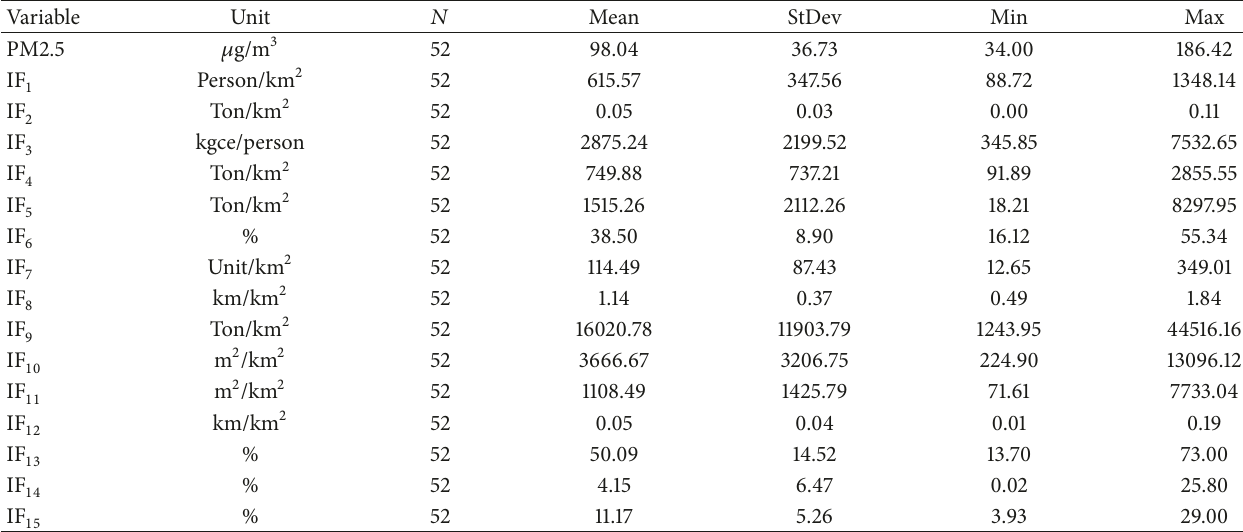
Table 5: Descriptive statistics of the influencing factors.